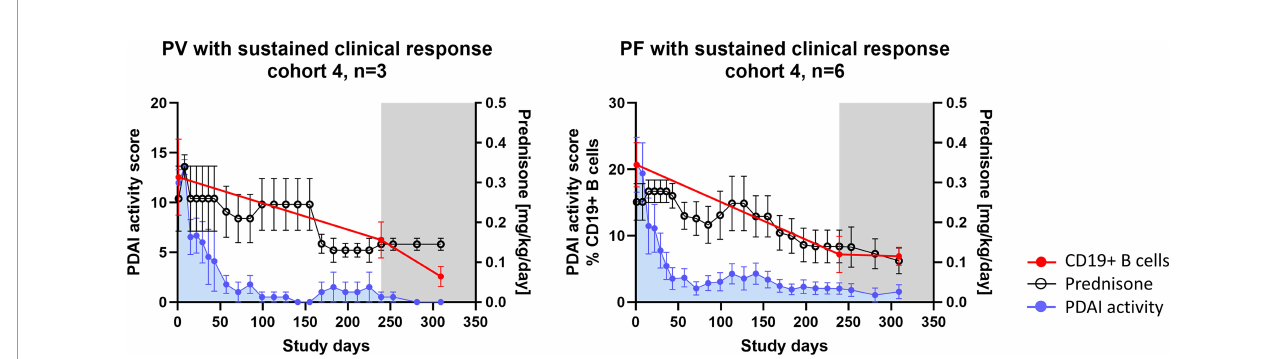
FIGURE 4 | Prednisone exposure in participants with prolonged efgartigimod treatment and observed B-cell immunomodulation ( n = 9). Summary pro fi les of the PV and PF participants achieving sustained clinical response illustrating prednisone dosages, PDAI activity scores, and frequency of total CD19+ B cells in peripheral blood when available. The gray shaded area indicates efgartigimod-free follow-up period. Error bars represent standard error of the mean (SEM). PV, pemphigus vulgaris; PF, pemphigus foliaceus; PDAI, pemphigus disease